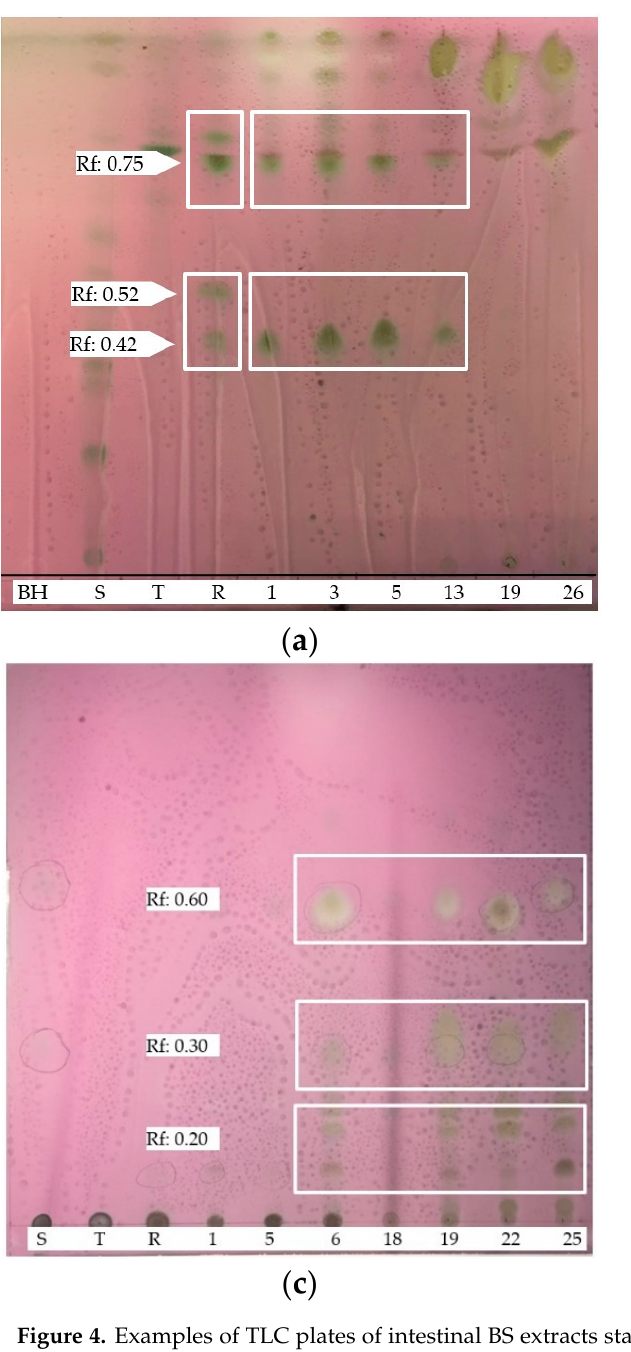
Table 2. Antibacterial activity of supernatants and crude extracts (mm) in agar diffusion assay against bacterial pathogens. Values are expressed as the mean ± standard deviation of three replicates. Highest values are highlighted in bold. Cell-Free Supernatants (CFSs) and Crude Extracts (CEs) (mm) Test